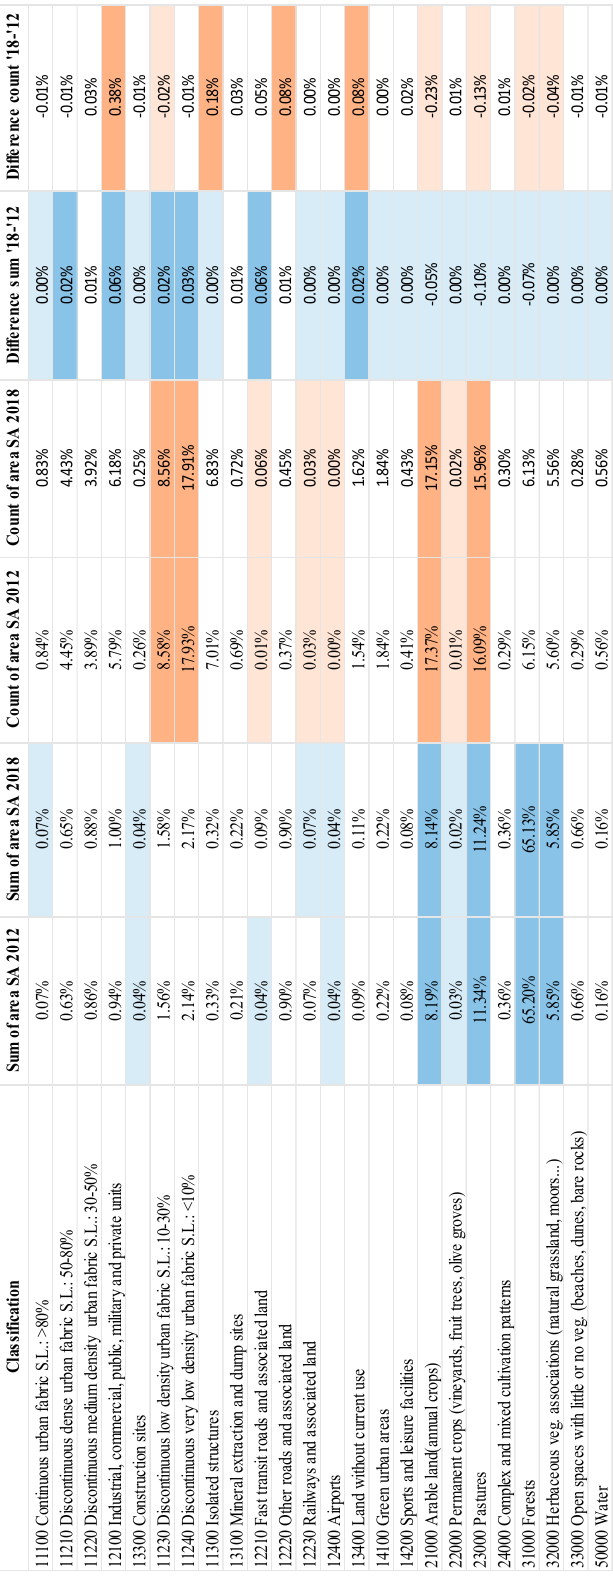
Figure A3. Total area and count of patches of Sarajevo for 2012–2018 and differences, showing the four highest and four lowest values.